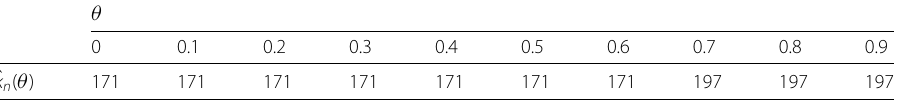
Table 2 The values of ˆ k n ( θ ) for different